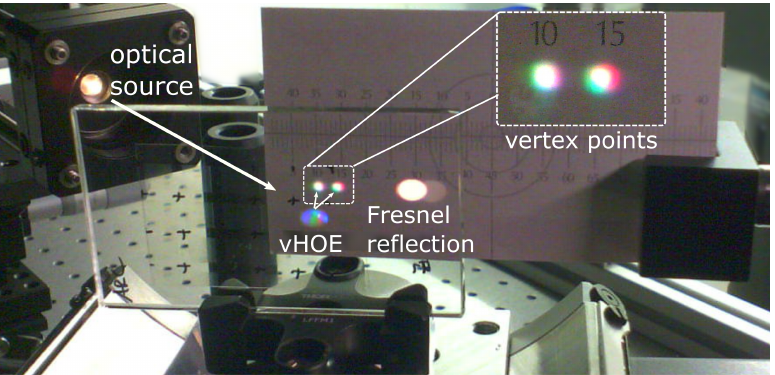
Figure 11. Collimated white light illumination of the vHOE under an incident angle matching the recording configuration. Two vertex points with red and green spectral proportions, diffracted by the vHOE as well as the Fresnel reflection of the collimated white light beam can be observed in the